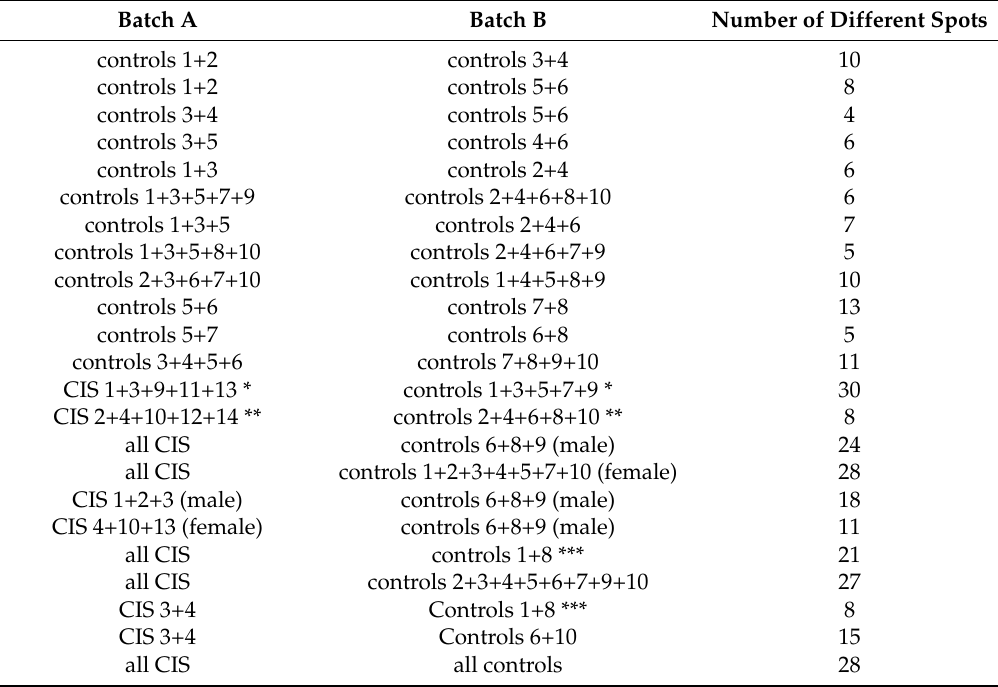
Table 3. Number of spots with different protein level in various matched sample batches between different gels. Batch A Batch B Number of Different Spots controls 1+2 controls 3+4 10 controls